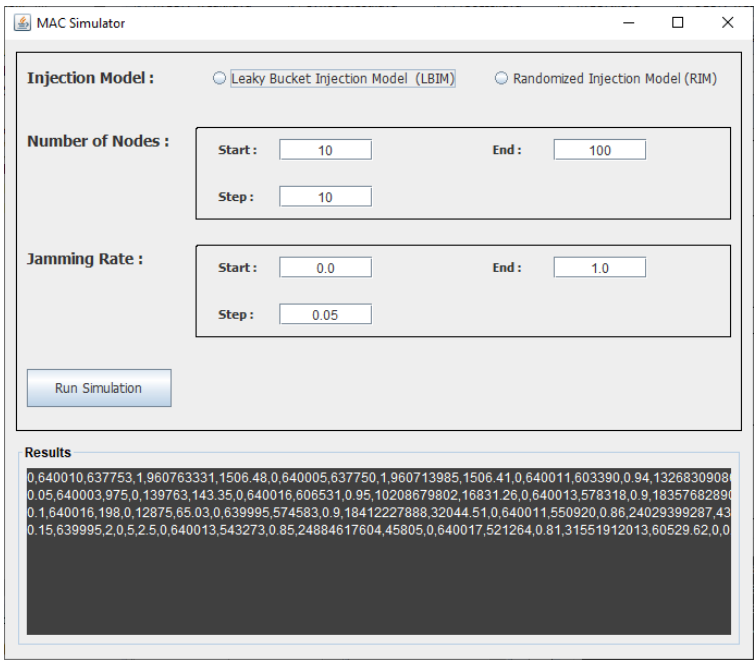
Figure 6. Screenshot of the developed multiple access channel (MAC) network